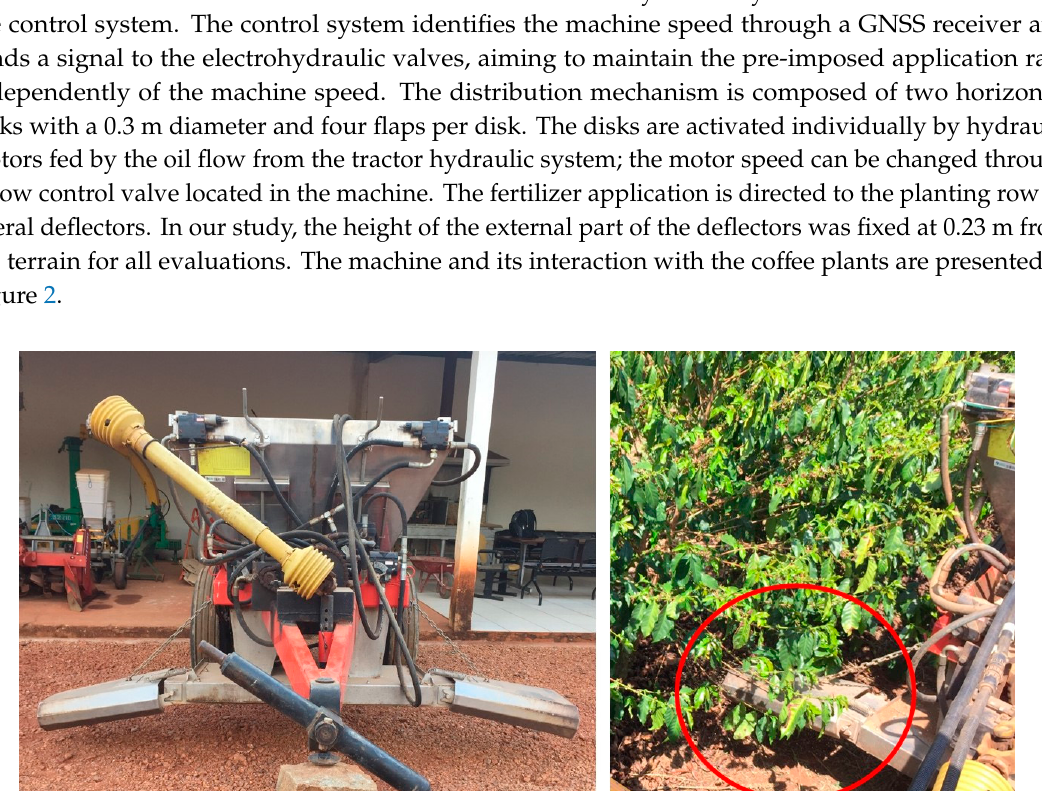
Figure 2. Machine evaluated and its interaction with coffee plants.